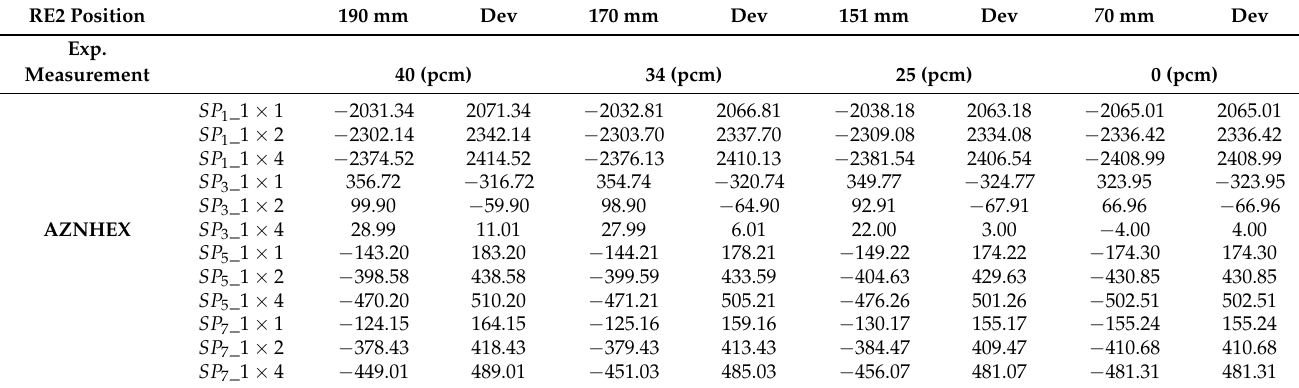
Table 8. Reactivity values and deviation in pcm from AZNHEX calculations with axial refinement and experimental